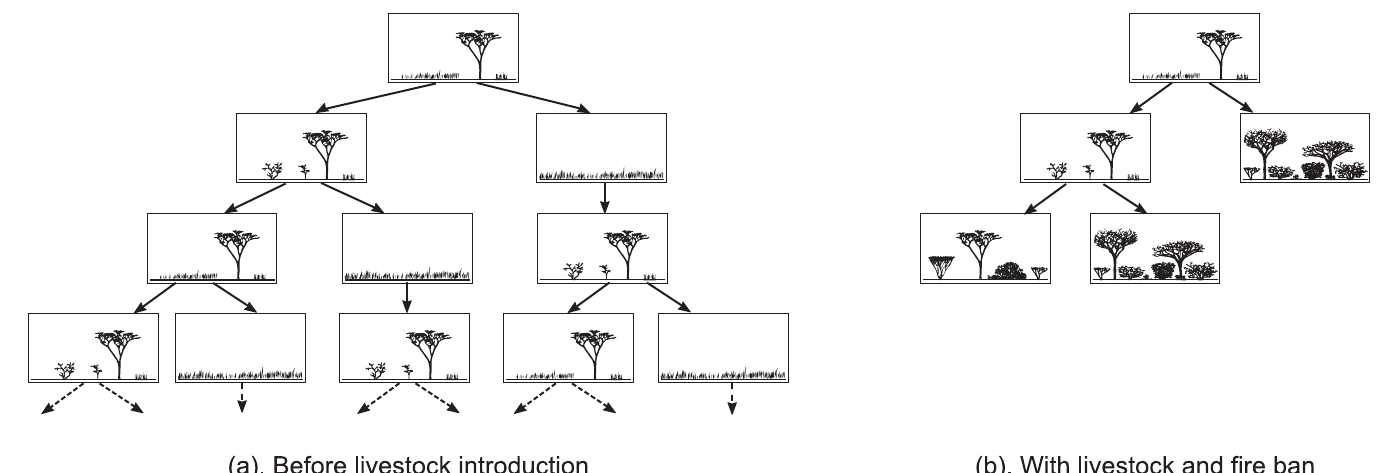
Fig 4. Computation trees rooted in the STMs of Fig 1. Each branch descending from the root represents a possible pathway in the corresponding STM. (a) The CT rooted in the open canopy woodland state of the STM of Fig 1a. As the pathways are infinite in this STM, the branches of the CT are also infinite, and thus the CT itself. (b) The CT rooted in the open canopy woodland state of the STM of Fig 1b. The grassland state is not reachable from the open canopy woodland state in this STM, and thus it does not appear in its CT. As the pathways are finite in this STM, the branches of the CT are also finite, and thus the CT itself. Formally the branches of a CT are usually assumed to be infinite, so that its pathways always carry on. In order to tackle this issue, the dead-end leaves of a CT can be interpreted as infinite pathways remaining in the same state.